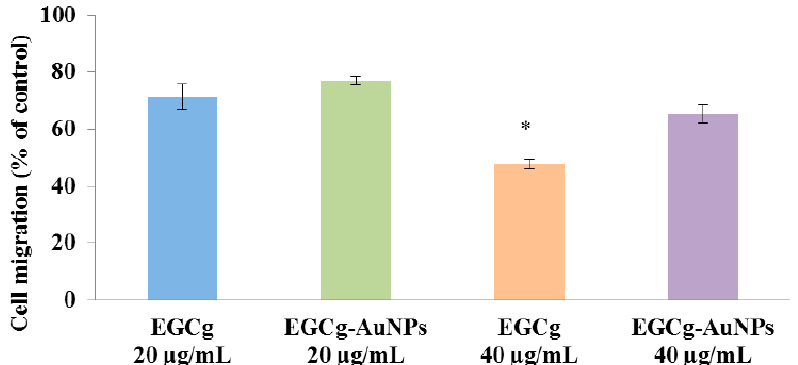
Figure 11. Effects of EGCg-AuNPs and free EGCg on HCASMCs migration with 24 h incubation time; mean ± SE ( n = 3). * p < 0.05 vs EGCg-AuNPs at same concentration. HCASMCs (Human coronary artery smooth muscle cells).